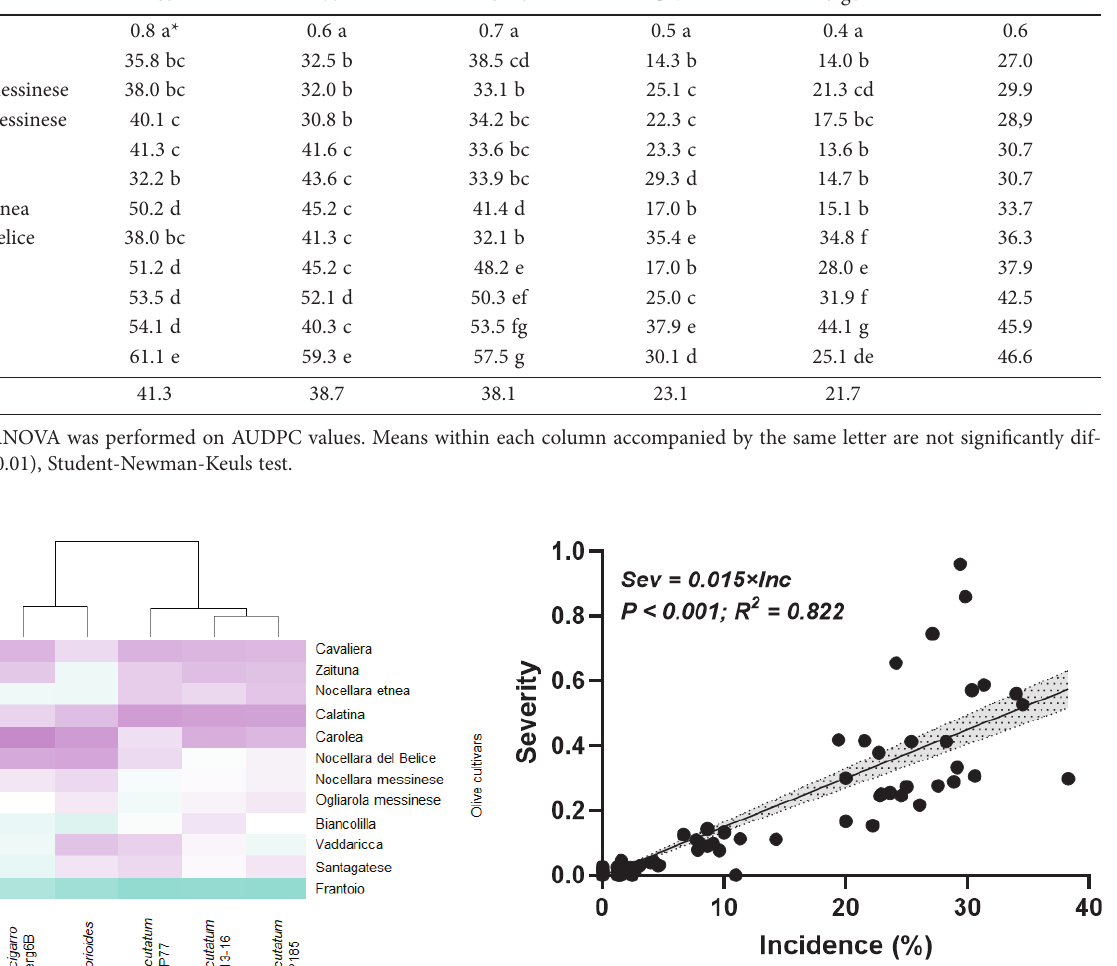
Figure 5. Relationship between fruit rot severity indices and fruit rot incidence (%) for olive fruit affected by Colletotrichum spp. in olive trees growing at the International Olive Germplasm Collec- tion (IOGC), Villa Zagaria, Enna,